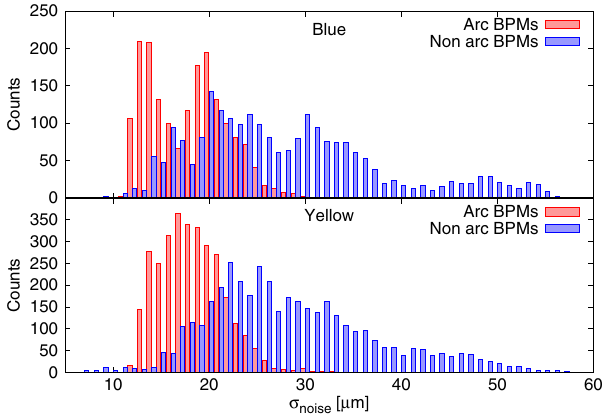
random calibration error with Gaussian distribution. As shown in Fig. 13, (cid:3) (cid:6) =(cid:6) increases linearly with respect , while (cid:3) is immune to BPM calibration error. At to (cid:3) cal (cid:2) c RHIC, BPM calibration error is estimated to be at the 1.0% level [21], which corresponds to a less than 2.0% system- atic error on beta-beat based on the simulation result in Fig. 13. The effect of BPM noise on the systematic error of beta- beat as well as phase-beat is shown in Fig. 14. The results are consistent with the analytic estimation of PCA in Eq. (17) of Ref. [5]. RHIC BPM noise was then estimated by SVD analysis of all turn by turn BPM data during experiment [22]. Figure 15 shows the calculated histogram of noise level for all BPMs. Evidently, the maximum BPM